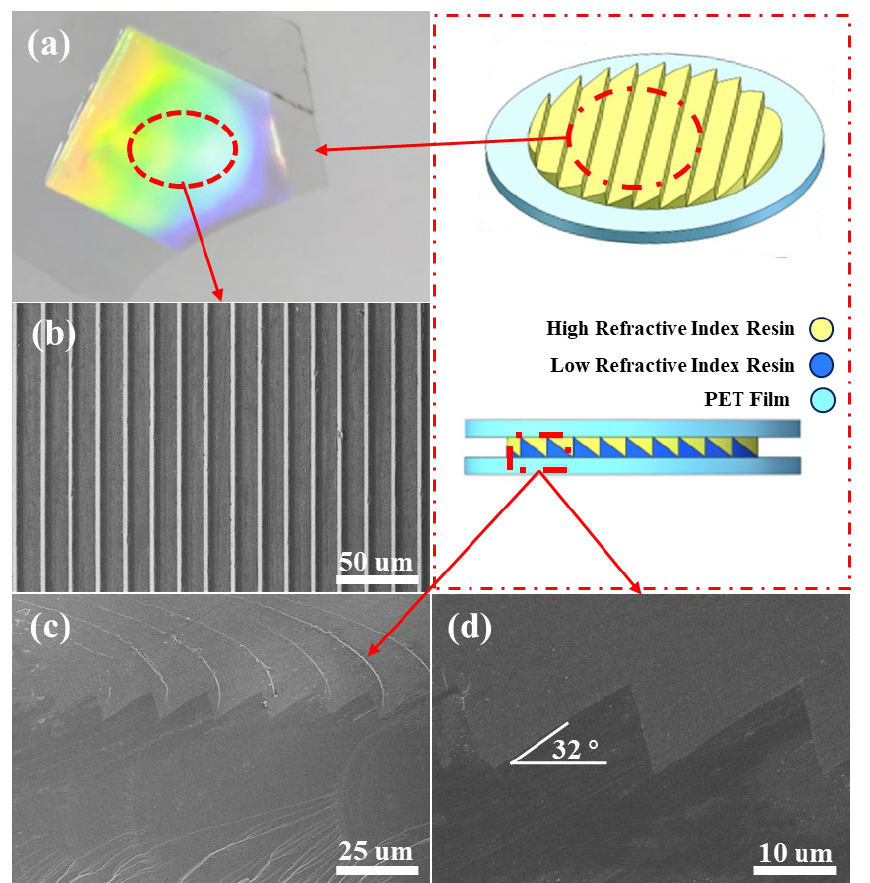
Figure 11. Microstructure and display effect of ARCs. ( a ) Display effect of single-layer high refractive resin after nanoimprinting. ( b ) SEMs of single-layer high refractive resin after nanoimprinting. ( c , d ) Microstructure of high-low refractive index composite ARCs films.